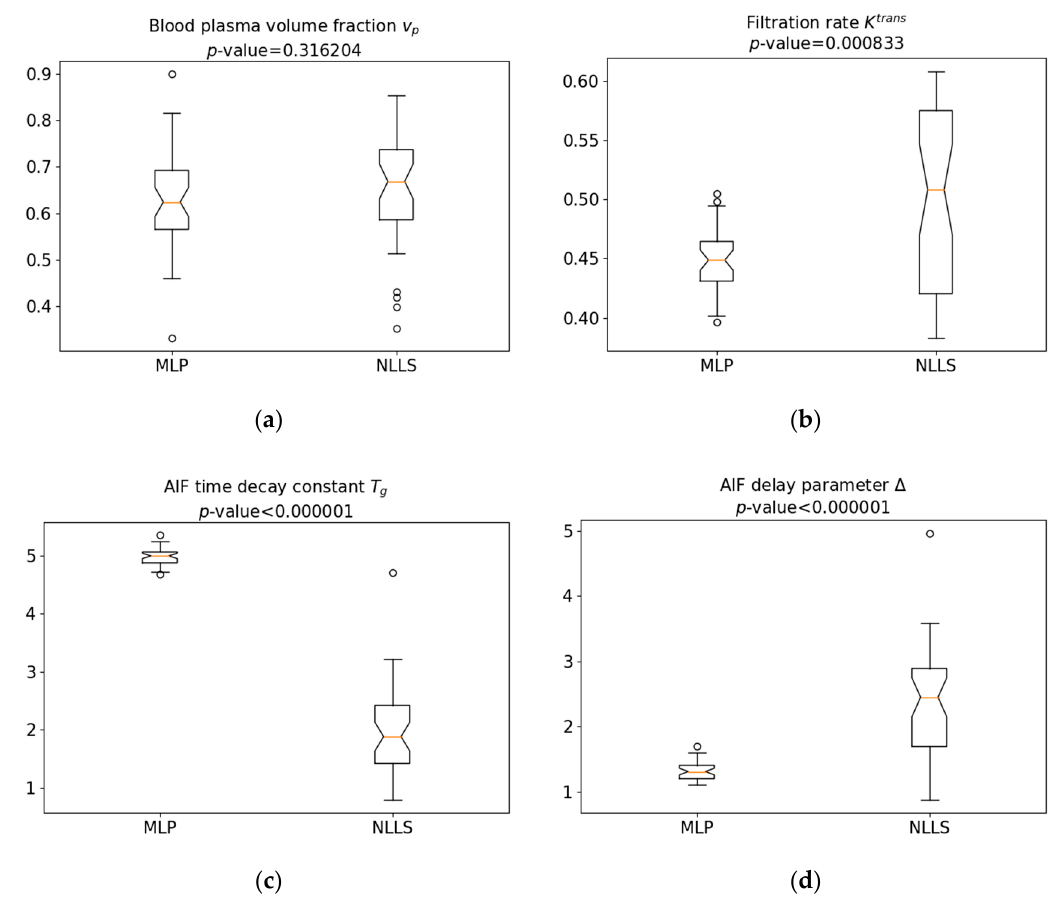
Figure 12. ( a – d ): Box plots showing distribution of 2CFM parameter values estimated by MLP and NLLS methods. Provided p -values were obtained for the t -test under the null hypothesis that mean estimated values are the same for both methods.